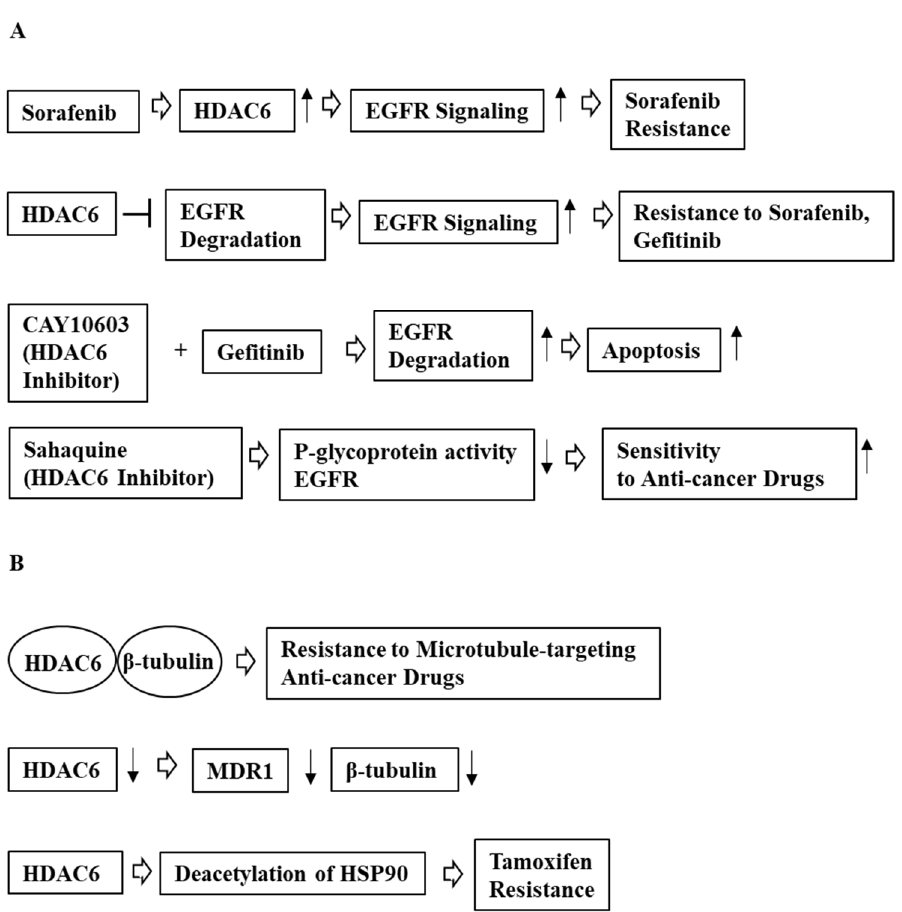
Figure 4. Mechanism of HDAC6-promoted anti-cancer drug resistance. ( A ) HDAC6 prevents EGFR degradation, activates EGFR signaling, and confers resistance to anti-cancer drugs. HDAC6 inhibition decreases the expression of EGFR, which enhances sensitivity of cancer cells to anti-cancer drugs. ( B ) HDAC6 enhances resistance to anti-cancer drugs by deacetylation of hsp90. HDAC6 binding to β -tubulin is necessary for conferring resistance to anti-cancer drugs. Downregulation of HDAC6 decreases the expression of MDR1. ↓ denotes negative regulation; ↑ denotes positive regulation; T bar arrows denote negative regulation; and hollow arrows denote direction of reaction.